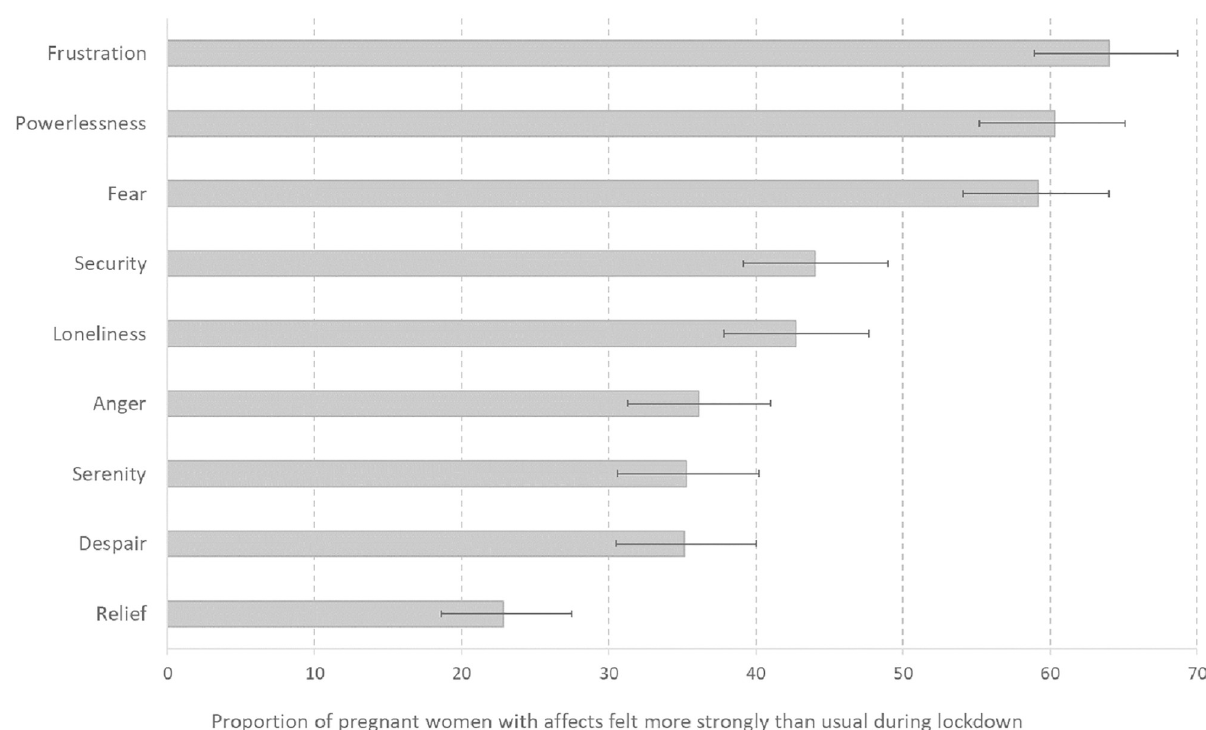
Fig 1. Affects felt more strongly than usual during lockdown (March-May 2020) in pregnant women who participated in the Covimater survey (n = 500), France (July 2020).